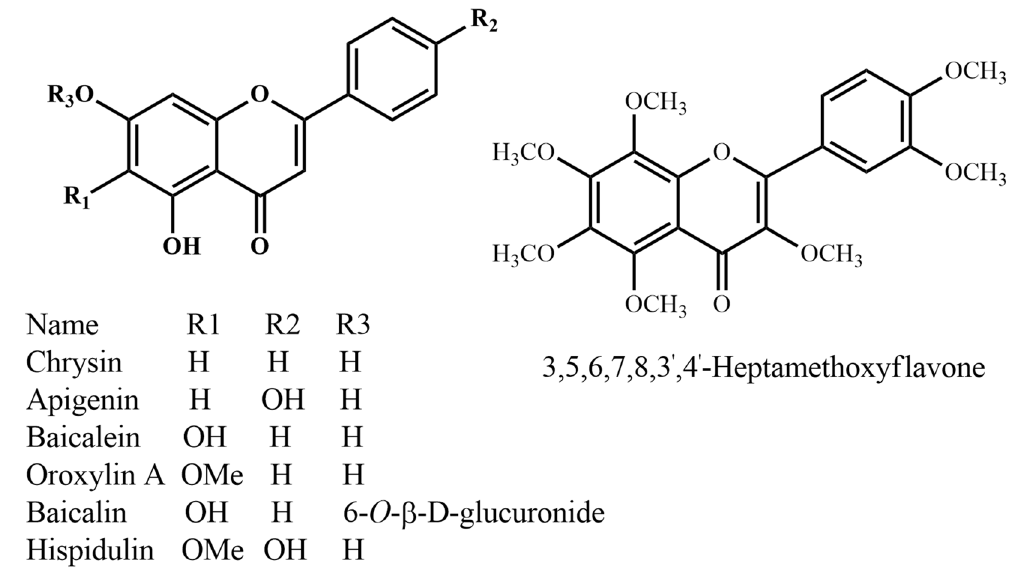
Fig. 11 Flavonoids